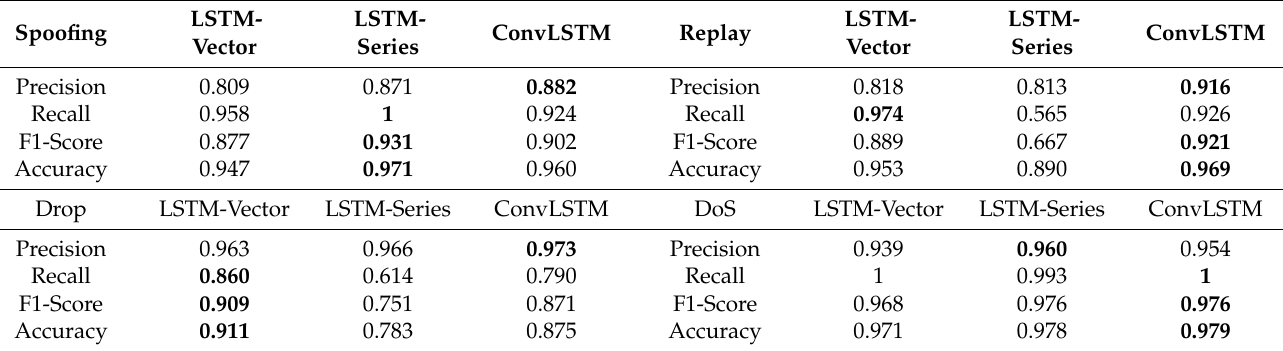
Figure 5. Comparison of network intrusion detection between proposed ConvLSTM-based method and benchmarks, i.e., LSTM-Vector and LSTM-Series: ( a ) ROC curve, ( b ) precision, recall, F1-score, and accuracy. Table 4. Numerical results: ConvLSTM and